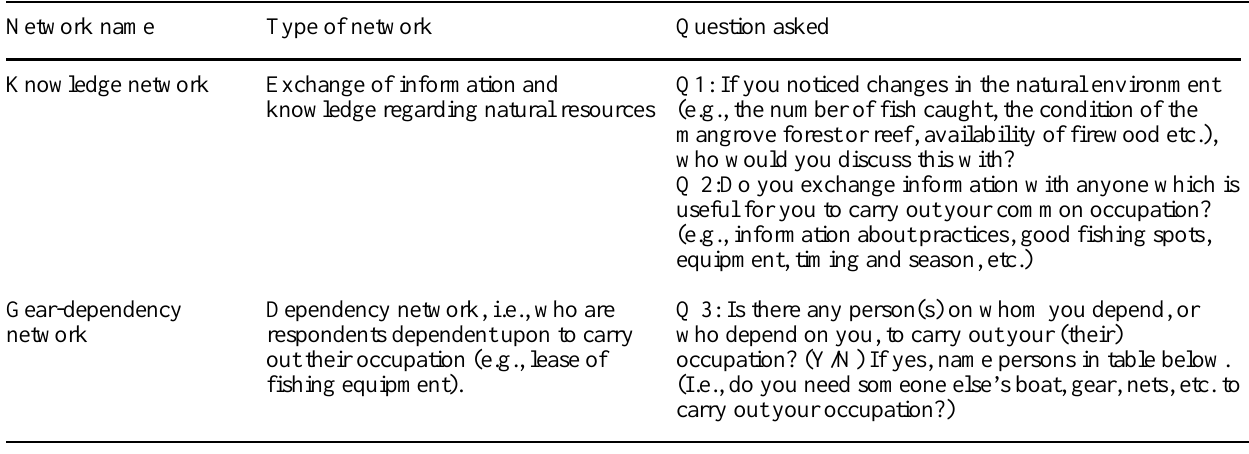
Table 1. Different types of social networks examined, and the questions used to elicit information about social ties for each